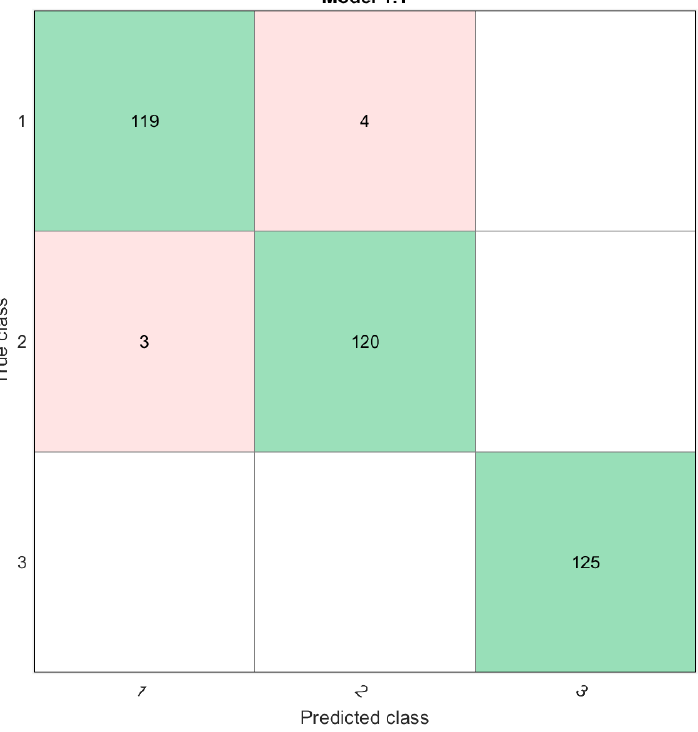
Figure 7. Confusion matrix after model training (1st group of data; green—correct classification, red—misclassification).